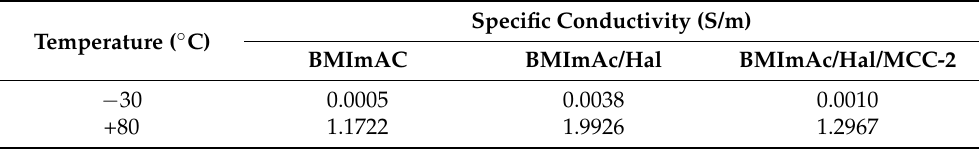
Table 6. Values of the specific conductivity of the